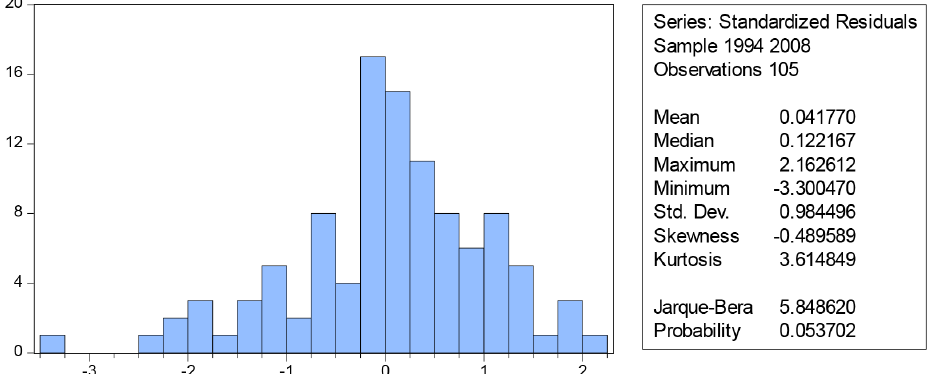
Fig. 3. Tests of residual normality for the EU-7 countries Source :